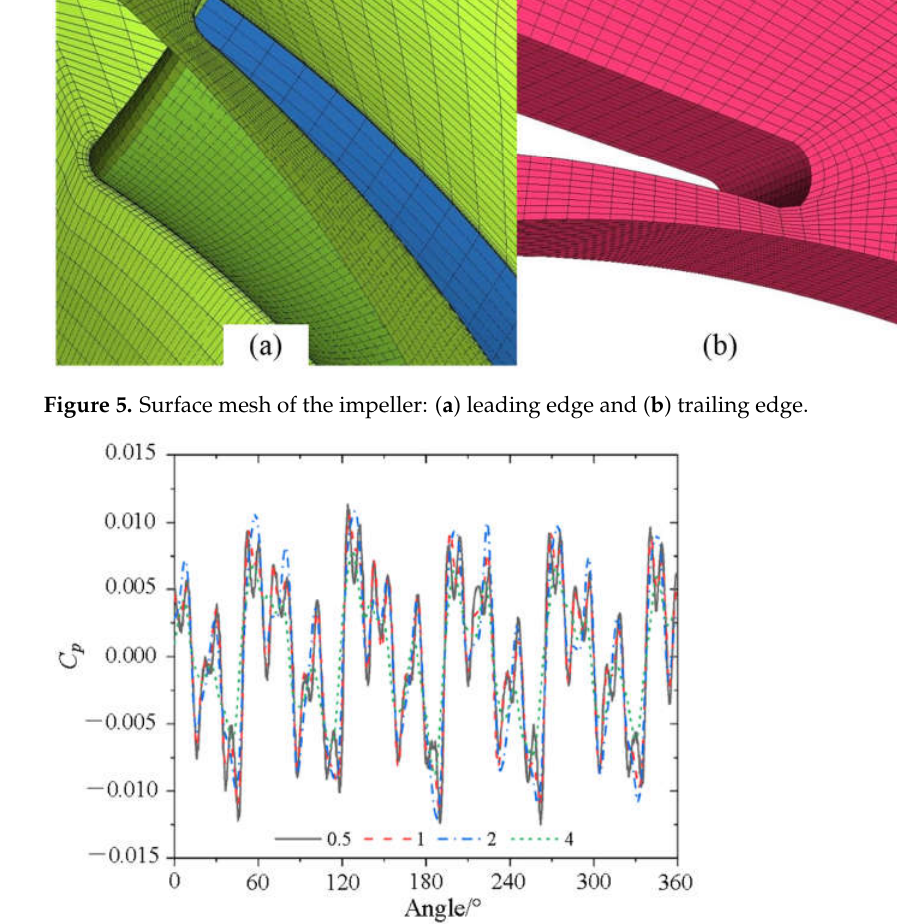
Figure 6. Time-step independence analysis.